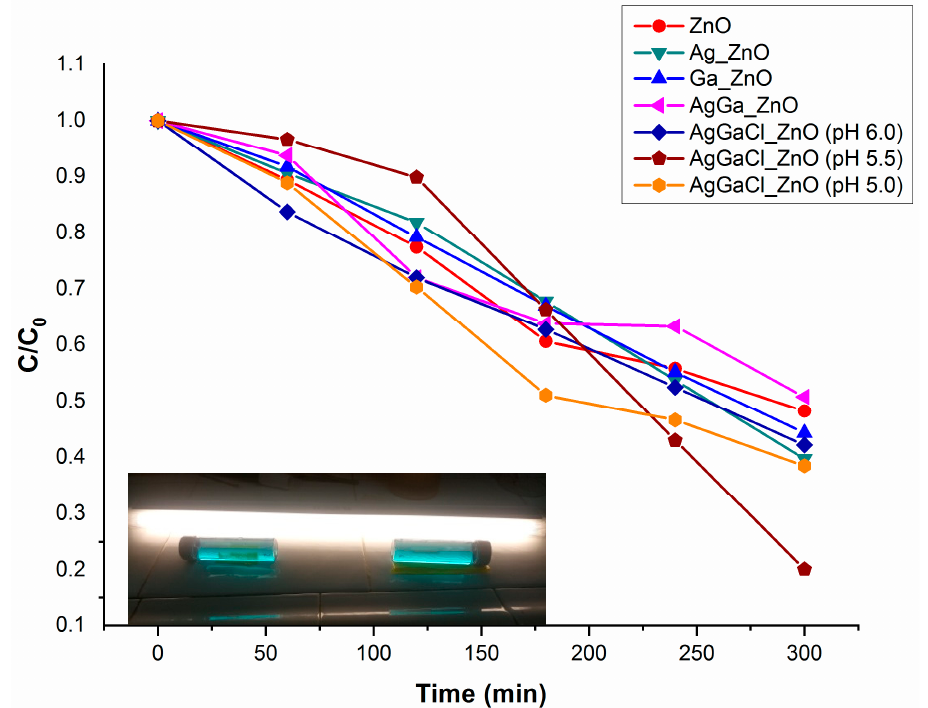
Figure 5. MB photodegradation kinetics under visible light irradiation for undoped and Ga, Ag, AgGa and AgGaCl-doped ZnO NRs. Inset: MB photodegradation experiment.